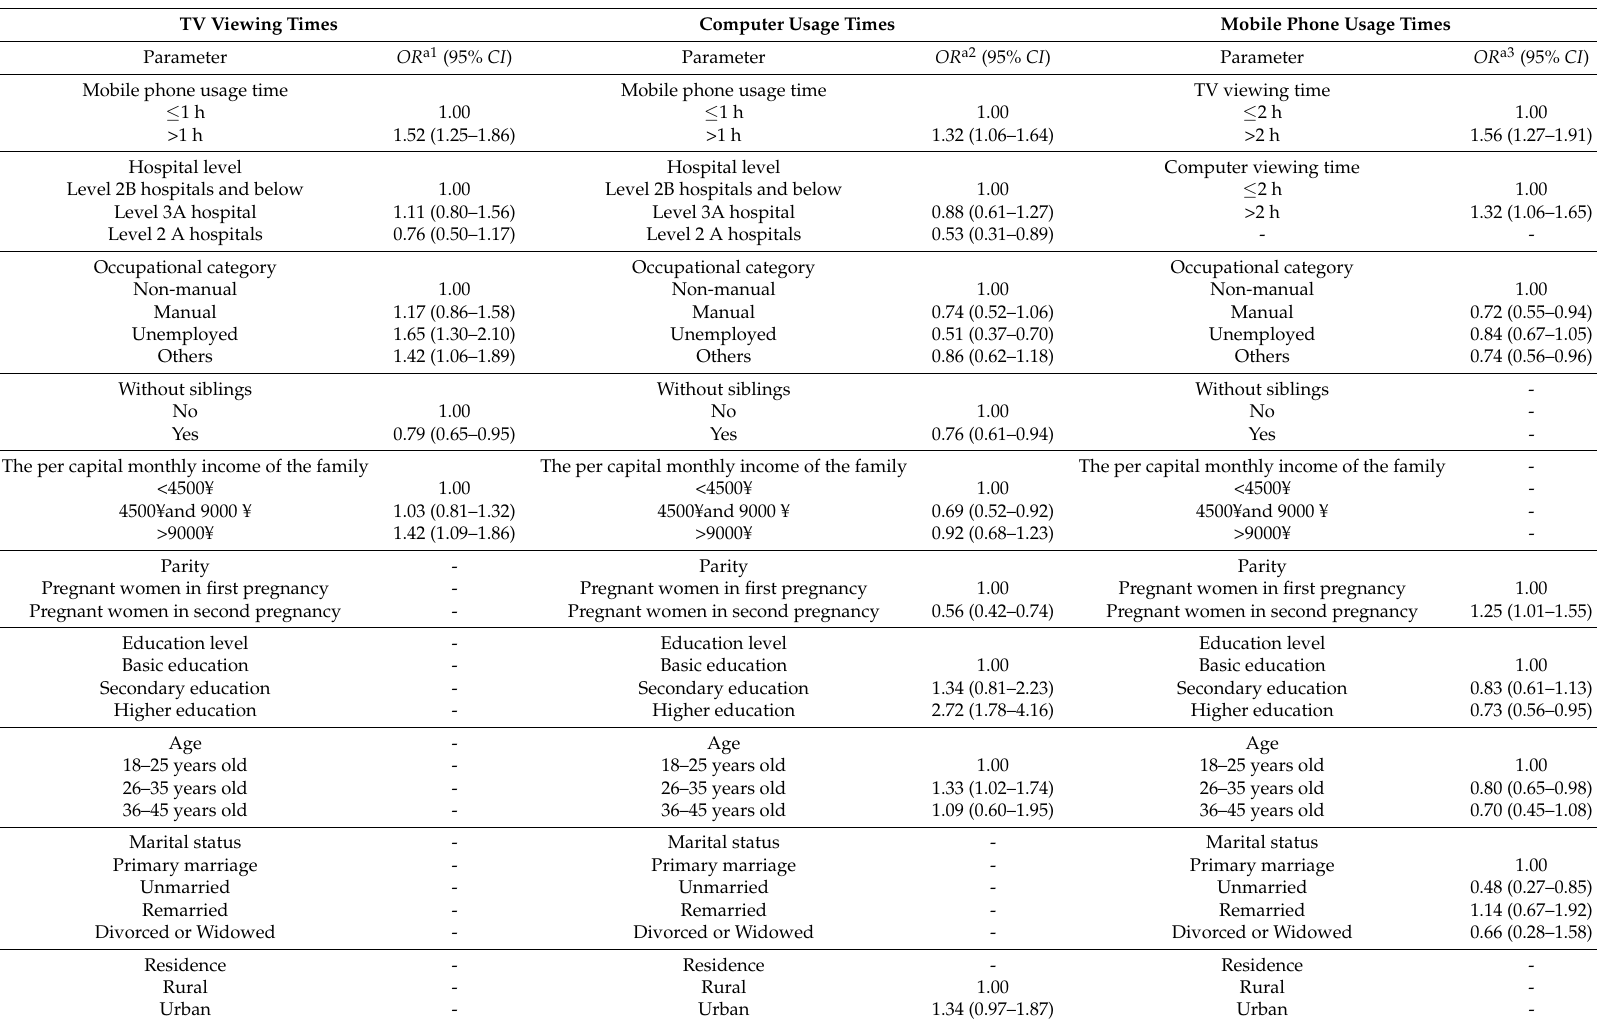
Table 5. Multivariate logistic regression model for prolonged TV, computer, and mobile viewing times among pregnant women, China,